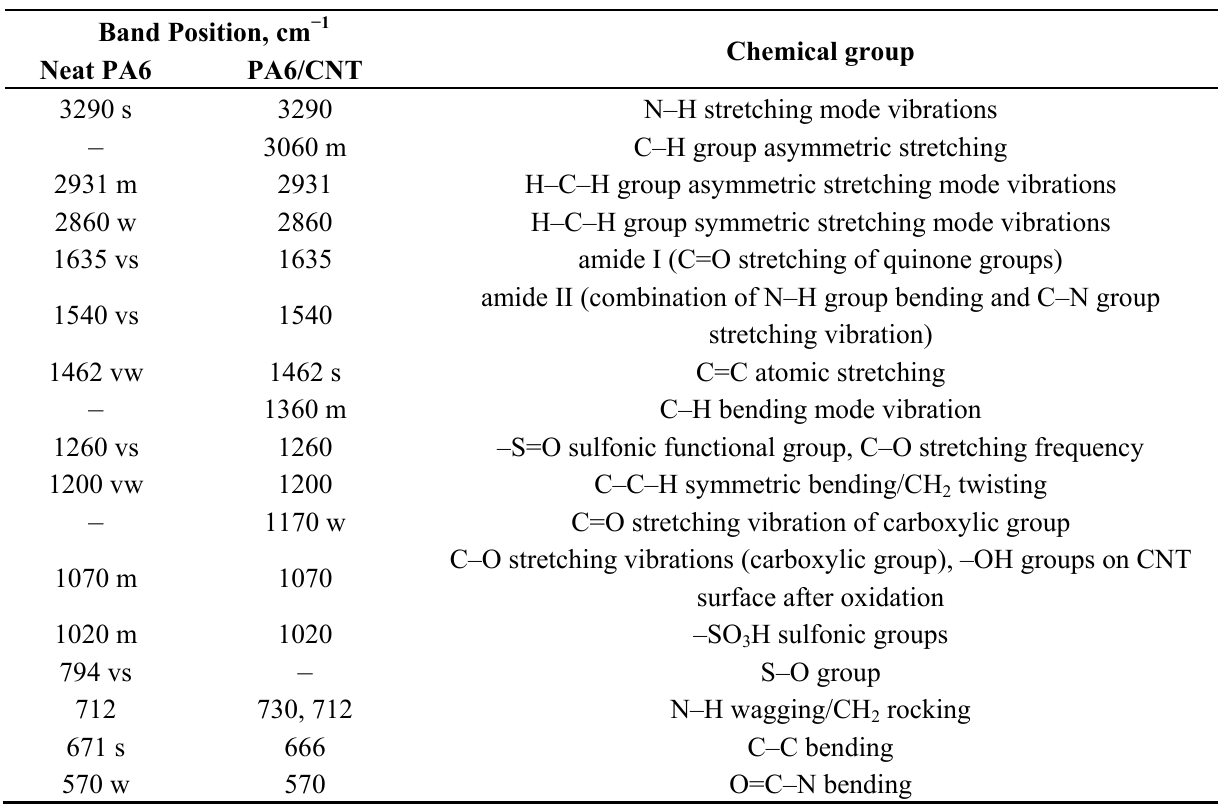
Table 1. Absorption bands and the chemical moieties responsible for their existence in neat PA6 and PA6/CNT composite samples